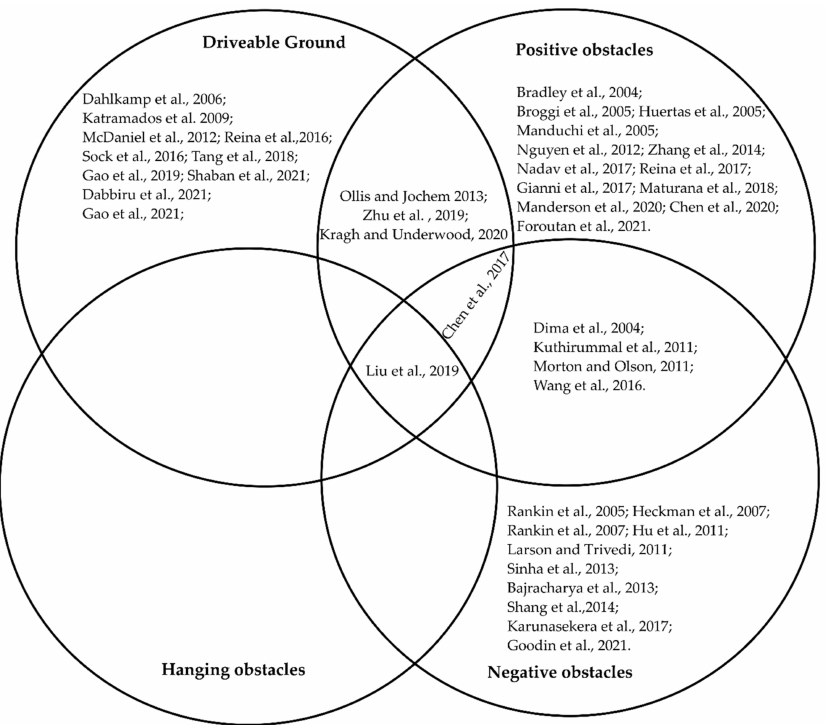
Figure 4. Distribution of the literature in different